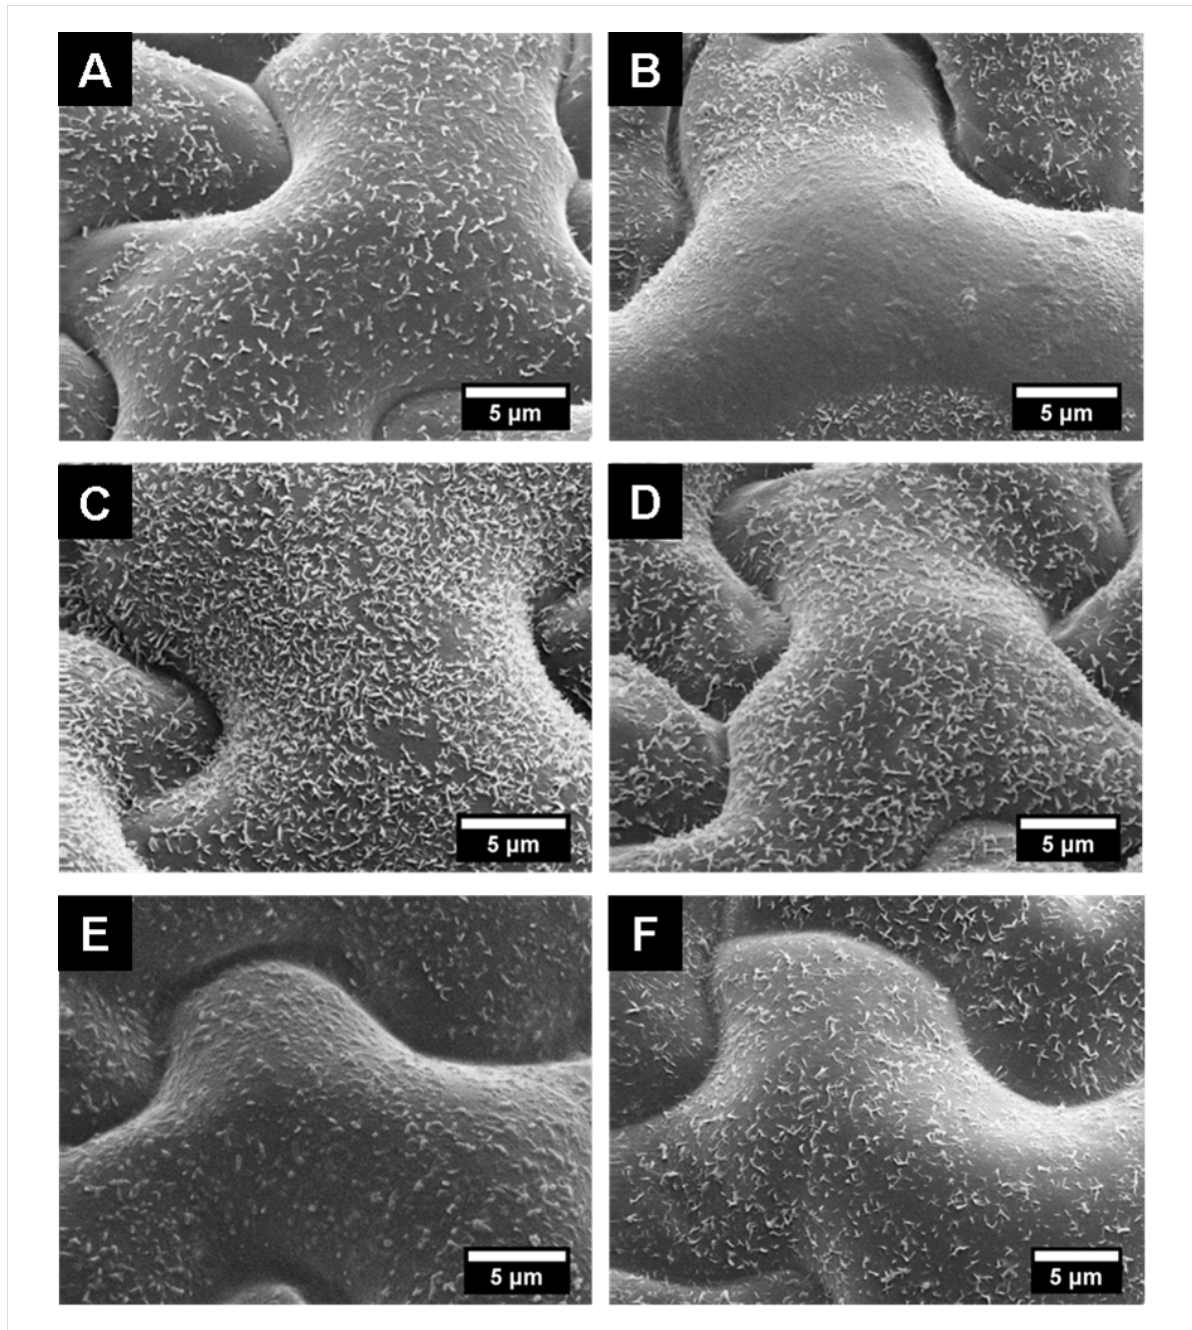
Figure 5: SEM micrographs of cryo-fixed upper leaf surfaces of Glycine max L. after 240 s of treatment with surfactants: SBO 10 (A), XP ED 00-75 (B), XP ED 28-11 (C), XP ED 28-12 (D), XP ED 28-13 (E), and XP ED 28-14 (F). For comparison of the wax structures see the SEM images before treatment in Figure